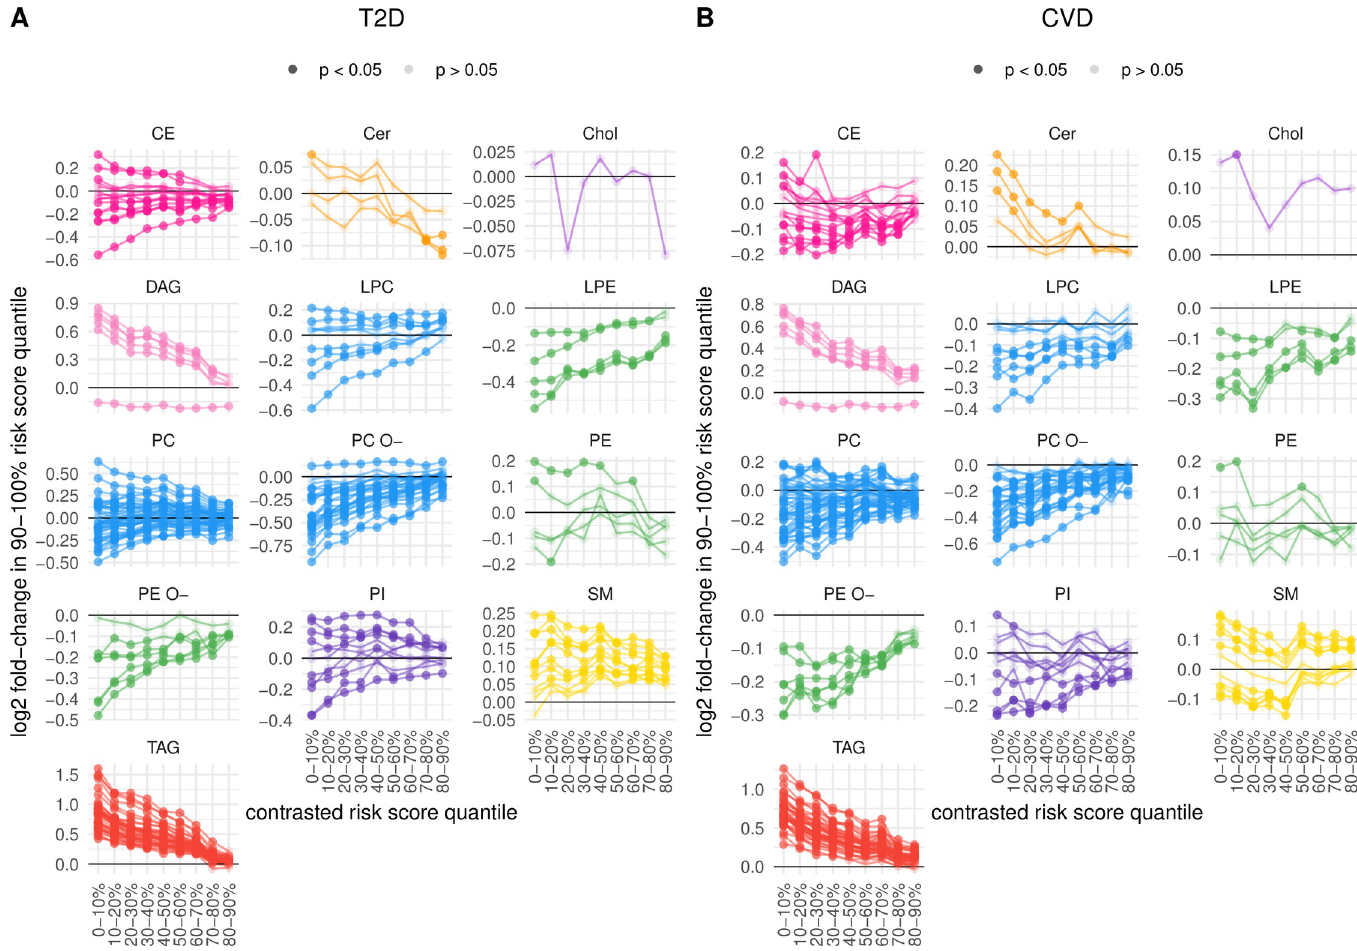
Fig 4. High-risk lipidome signatures. Shown are fold-changes of lipid concentrations in the individuals of the 90%–100% N + L + P + C risk score quantile relative to those of each of the other 9 quantiles for T2D (A) and CVD (B). Fold-change values of separate quantile comparisons per species are shown by points, which have high opacity if the difference of mean lipid concentration was statistically significant (after correction for multiple testing) according to a t test; otherwise, points are drawn with high transparency for nonsignificant changes. Positive and negative values correspond to, respectively, increased and decreased concentrations in the high-risk 90%–100% quantile participants, while the horizontal line at zero indicates no change. Points corresponding to the same lipid species are connected by a line. See also S2 Table for species names. The data underlying this figure may be found in S1 Data. CE, cholesteryl ester; Cer, ceramide; Chol, cholesterol; CVD, cardiovascular disease; DAG, diacylglyceride; FBG, fasting blood glucose; HbA1c, glycated hemoglobin; HDL, high-density lipoprotein; LDL, low-density lipoprotein; LPC, lysophosphatidylcholine; LPE, lysophosphatidylethanolamine; PC, phosphatidylcholine; PC O-, ether- phosphatidylcholine; PE, phosphatidylethanolamine; PE O-,